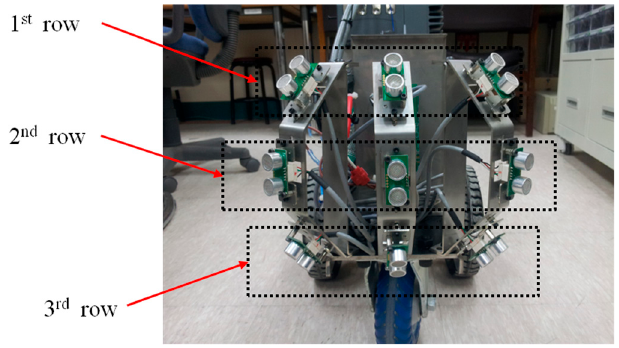
Figure 7. Arrangement of sensors in the developed ETA.